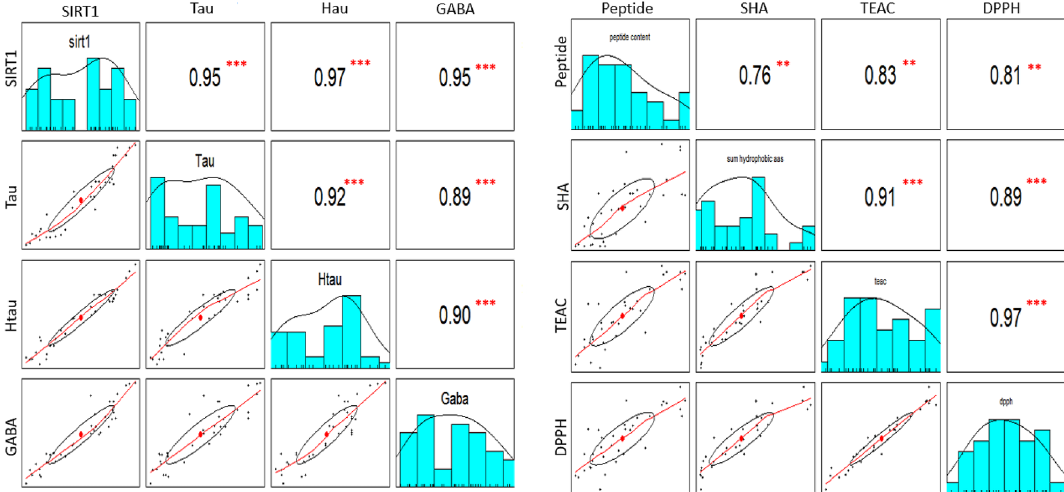
Figure 2. Pairwise scatter plot matrix, distribution, and Pearson correlation coefficients (R) for comparisons among specific amino acids, peptide content, antioxidant and SIRT1 activities in enzymatic protein hydrolysates from 36 algae species. On the bottom of the diagonal, the bivariate scatter plots with a fitted line, and on the top of the diagonal, the value of the correlation (R) plus the significance level as asterisks (** p < 0.01; *** p < 0.001). Peptide = Peptide concentration; SHA = Sum of hydrophobic amino acids; DPPH and ABTS = antioxidant activities; SIRT1 = EPH modulators of Sirtuin 1; GABA = Gamma amino butyric acid; Tau: taurine; Htau: